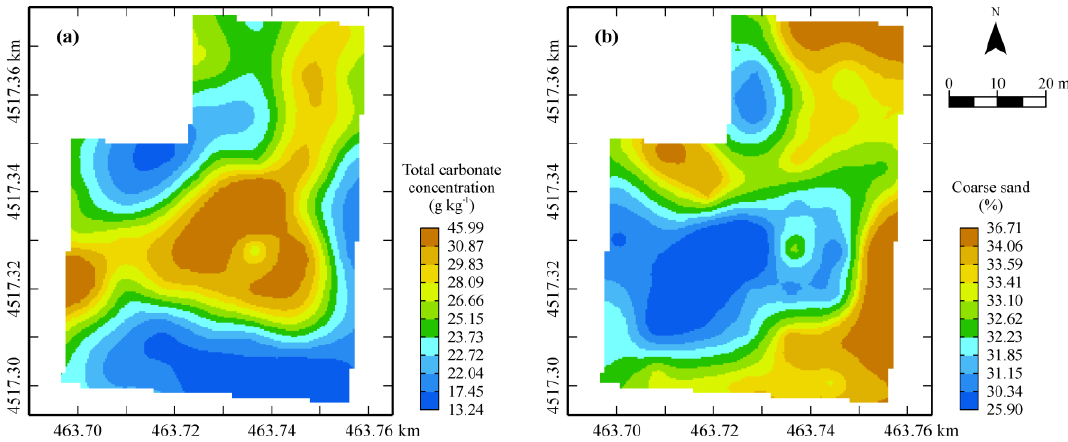
Figure 8. Cokriged maps of total carbonate ( a ) and coarse sand ( b ).